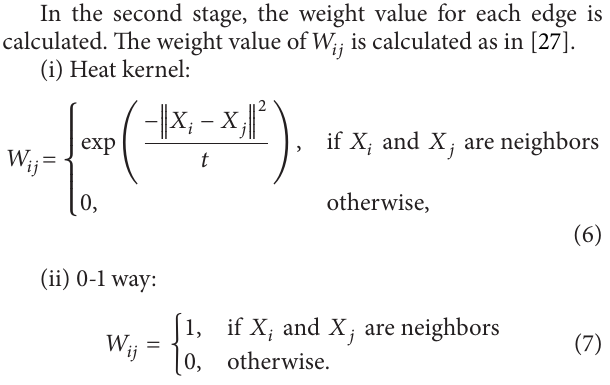
nearest neighbors of 𝑗 , or 𝑗 is one of the 𝑘 nearest neighbors of 𝑖